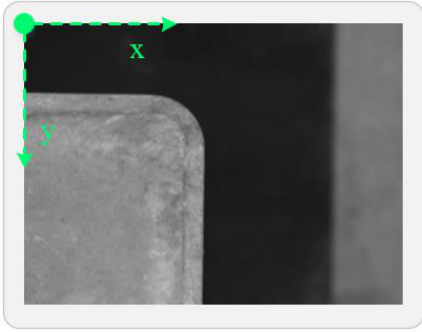
Figure 5. Sample images taken in actual scenes.